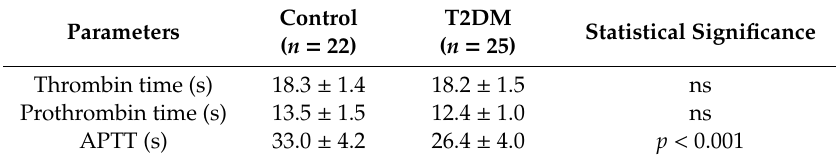
Table 2. The comparison of the selected coagulation parameters (thrombin time, prothrombin time, and activated partial thromboplastin time (APTT)) of T2DM patients and control subjects.